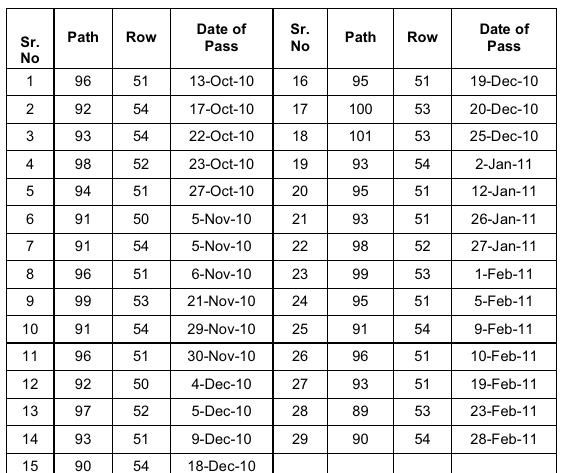
Unsupervised classification using ISODATA clustering was used to form data clusters in spectral domain. Clustering is based on the natural grouping of pixels in image data when they are plotted signature. The ISODATA method uses minimum spectral distance to assign a cluster for each candidate pixel. The process begins with a specified number of arbitrary cluster means or the means of existing signatures, and then it processes repetitively, so Table 1: Details of multi-date AWiFS data used that those means shift to the means of the clusters in the